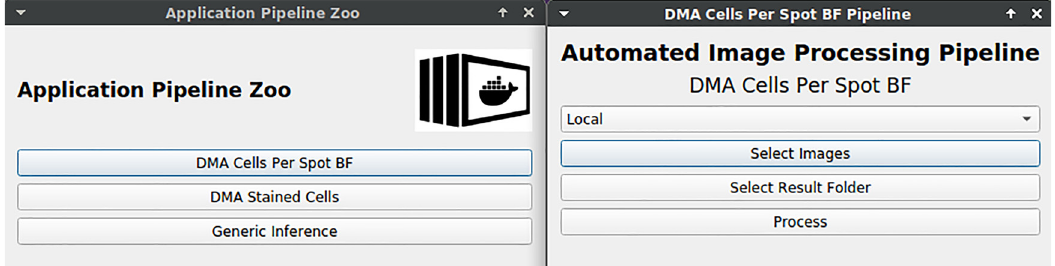
Figure 13: DNN application. User interface is shown for submitting a job to a computing server via REST API in order to apply image processing pipelines including a